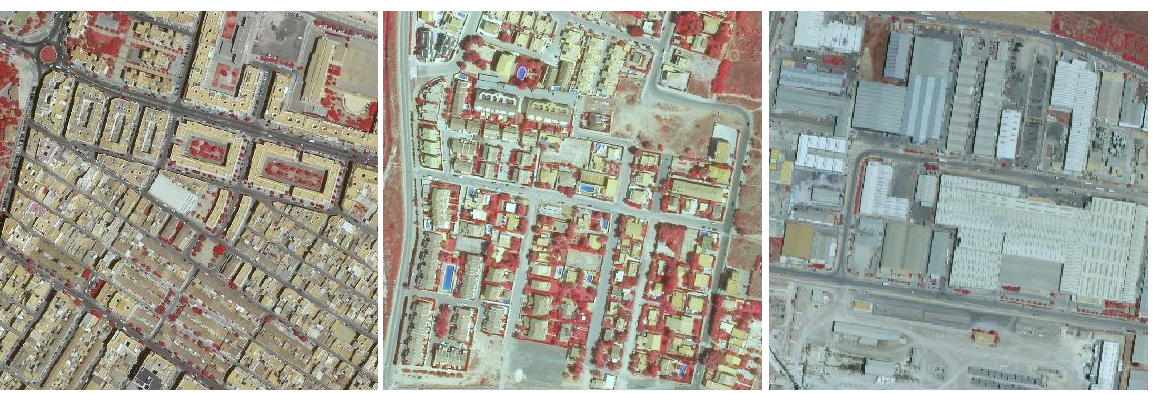
Figure 4. Examples of the building types defined: urban (left), suburban (center), and industrial (right). All the images belong to the study area of Sagunto.